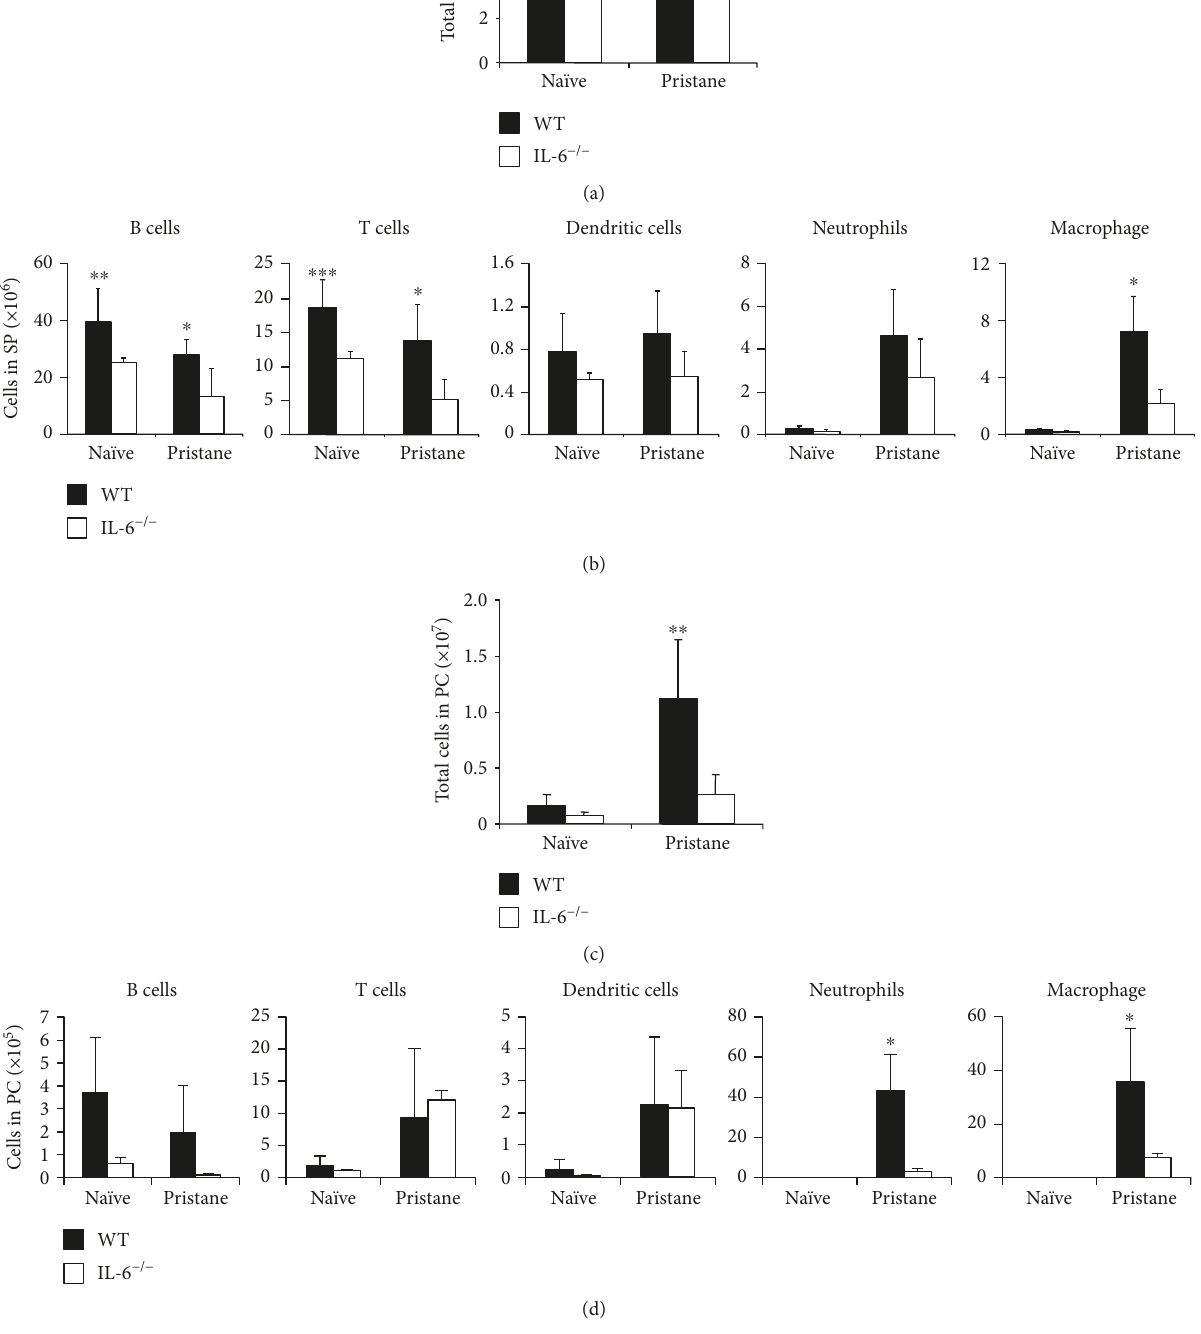
Figure 2: IL-6 de fi ciency decreased the recruitment of splenic macrophages in response to pristane treatment. (a, b) IL-6 − / − mice and WT mice were injected with 300 μ L (8.3 × 10 − 4 mol) of pristane and sacri fi ced at three weeks thereafter. Single cell suspensions of the spleen (SP) and peritoneal cavity (PC) from pristane-injected WT and IL-6 − / − mice were prepared for cellularity analysis by fl ow cytometry. The total cell number and the number of each cell type were calculated, respectively. (c, d) The total number of cells or the number of each cell type in the PC was analyzed in the same way. The di ff erence between WT and IL-6 − / − mice is shown. Data represent two independent experiments. ∗ p < 0 05 , ∗∗ p < 0 01 , and ∗∗∗ p < 0 001